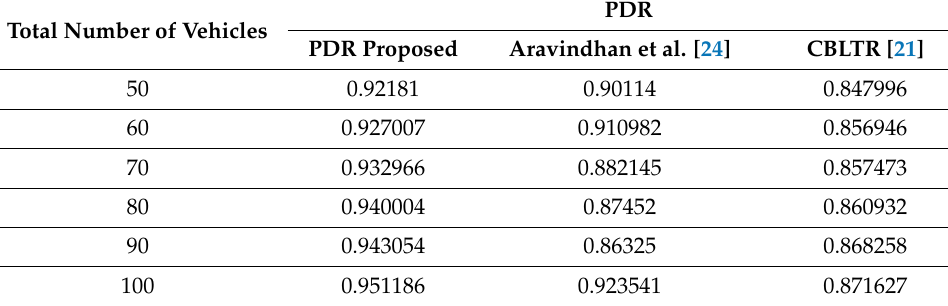
Table 5. PDR versus vehicular nodes in Area (1200 ×